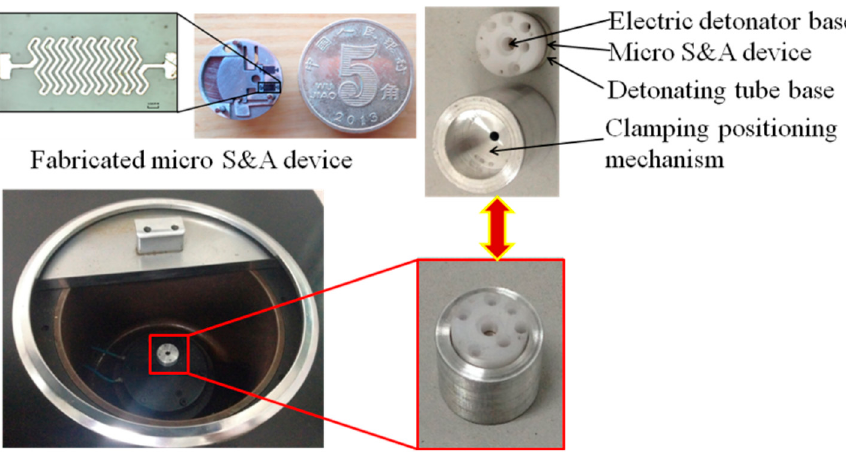
Figure 9. The fabricated micro S & A module and the experimental setups.